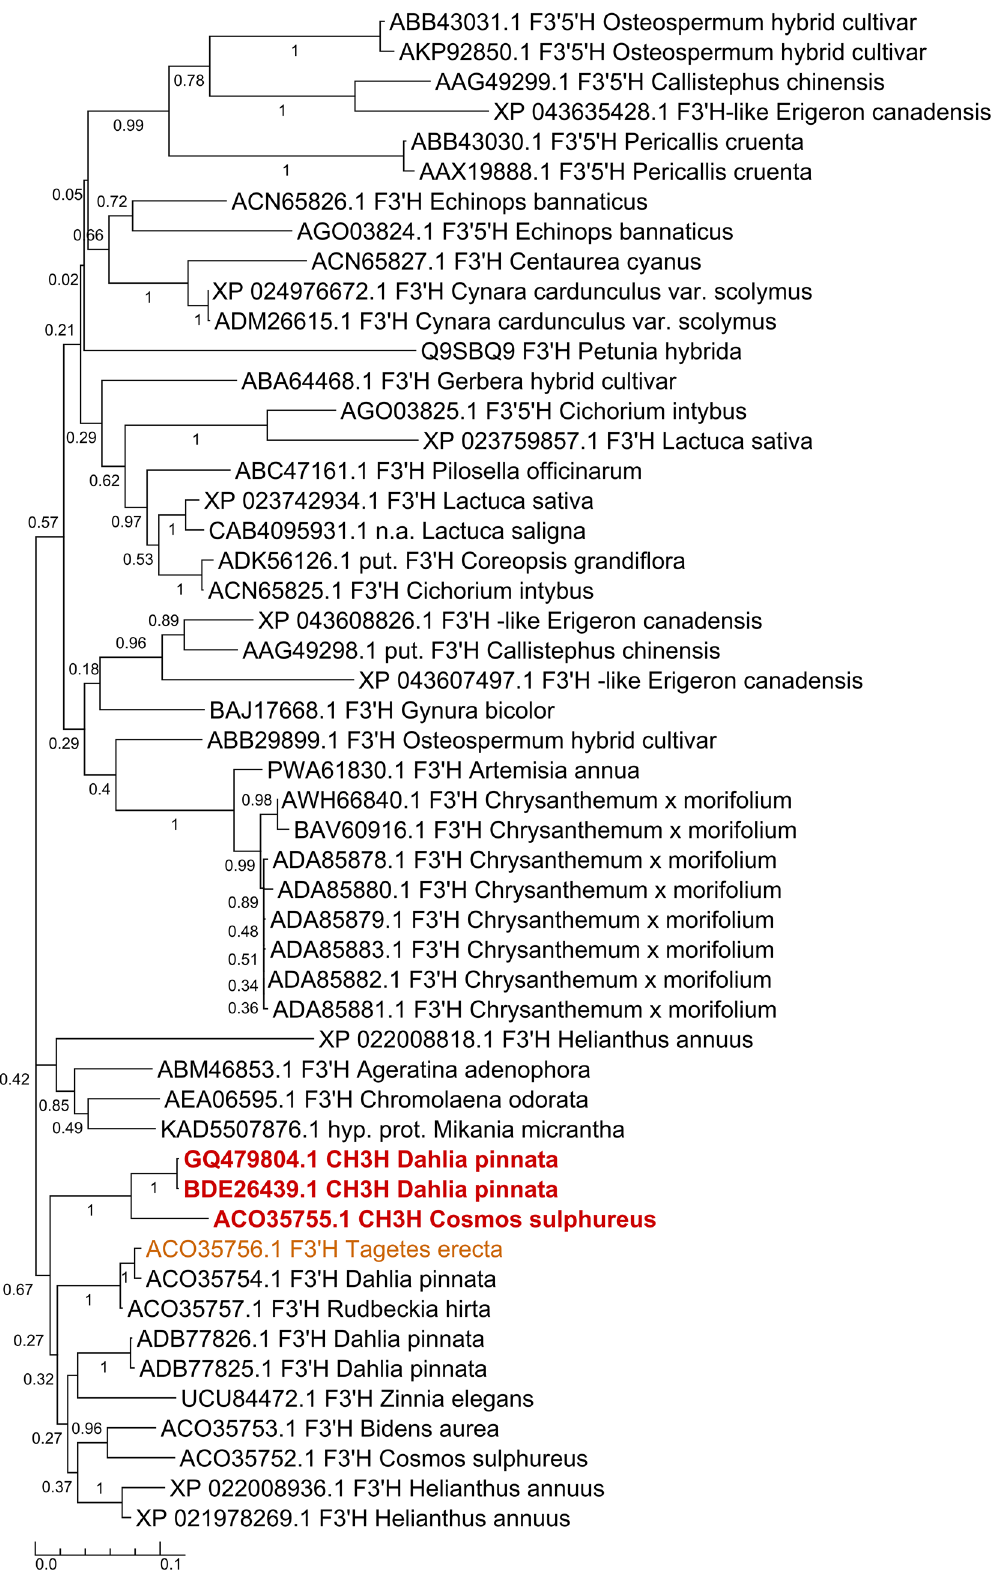
Figure 2. Phylogenetic tree of available Asteraceae CYP75B amino acid sequences. The enzymes exhibiting chalcone hydroxylase activity are coloured red and the F3 ′ H from Tagetes erecta showing weak chalcone hydroxylase activity is coloured orange. Note: The sequence of F3 ′ H from Petunia hybrida (Q9SBQ9) has been included for comparison with F3 ′ H from non-Asteraceae